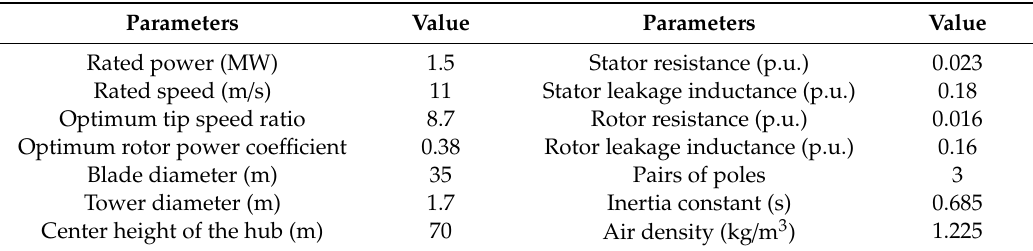
Table 2. Parameters of 1.5MW DFIG wind turbine.